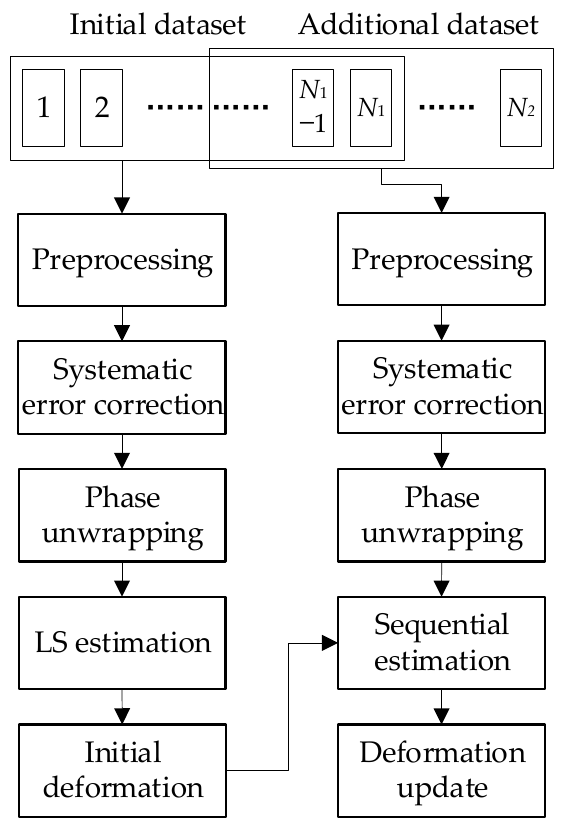
Figure 1. Flowchart of the near - real - time GB-InSAR deformation measurement method.